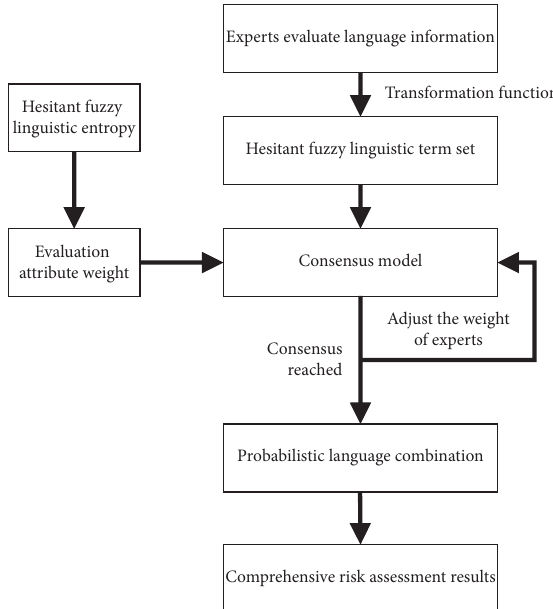
Figure 2: Comprehensive evaluation process of the talent growth factor